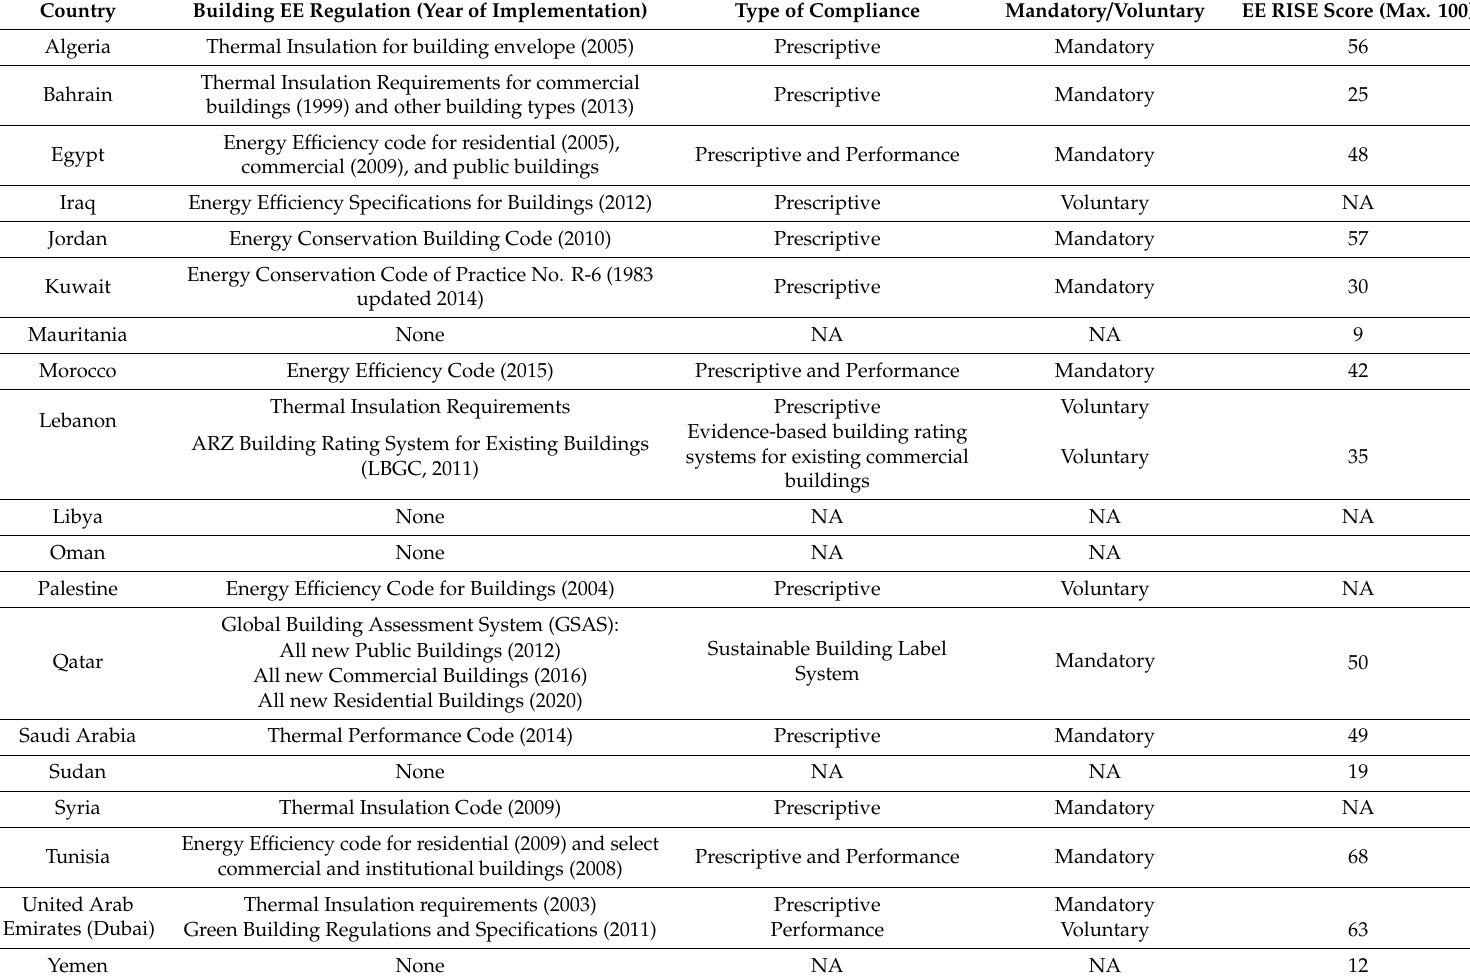
Table 18. Status of building energy e ffi ciency regulations in Arab